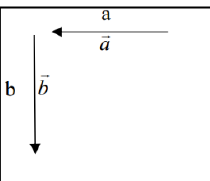
Figure 1. Edge Figure 1. Edge vector.